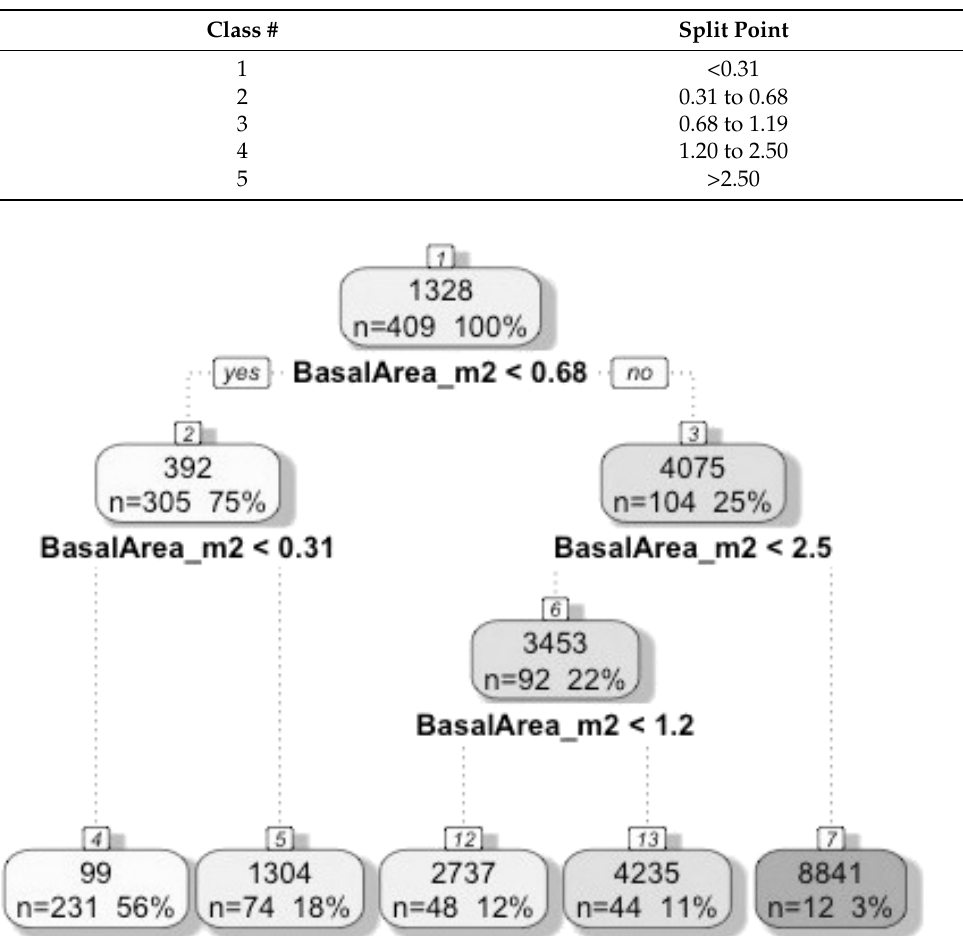
Table 7. Split points used to partition plot data into five structure classes based on BA (m 2 plot − 1 ).